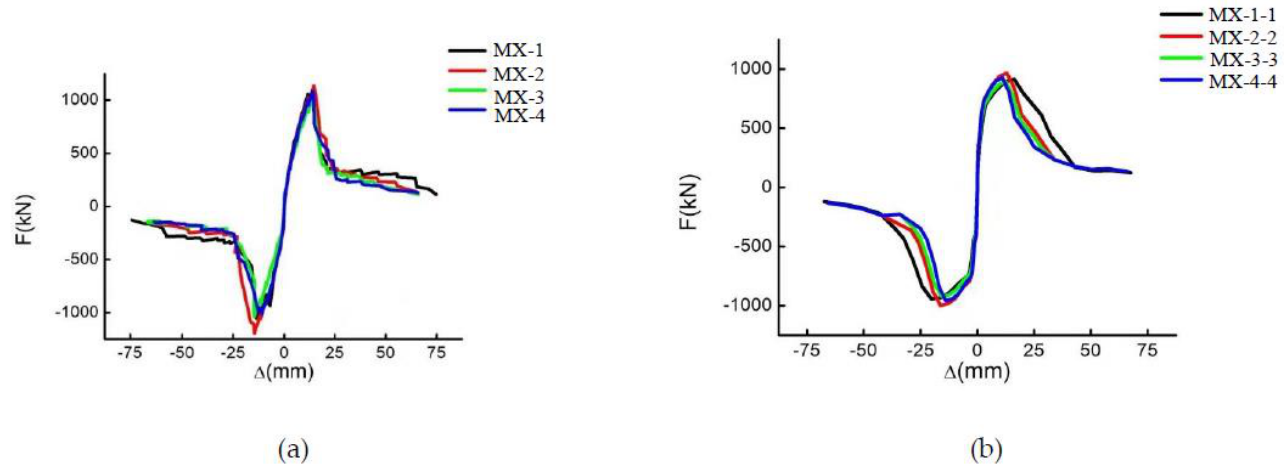
Figure 6. Skeleton curves obtained from simulation and experimental tests. ( a ) Actual and ( b ) virtual test pieces.